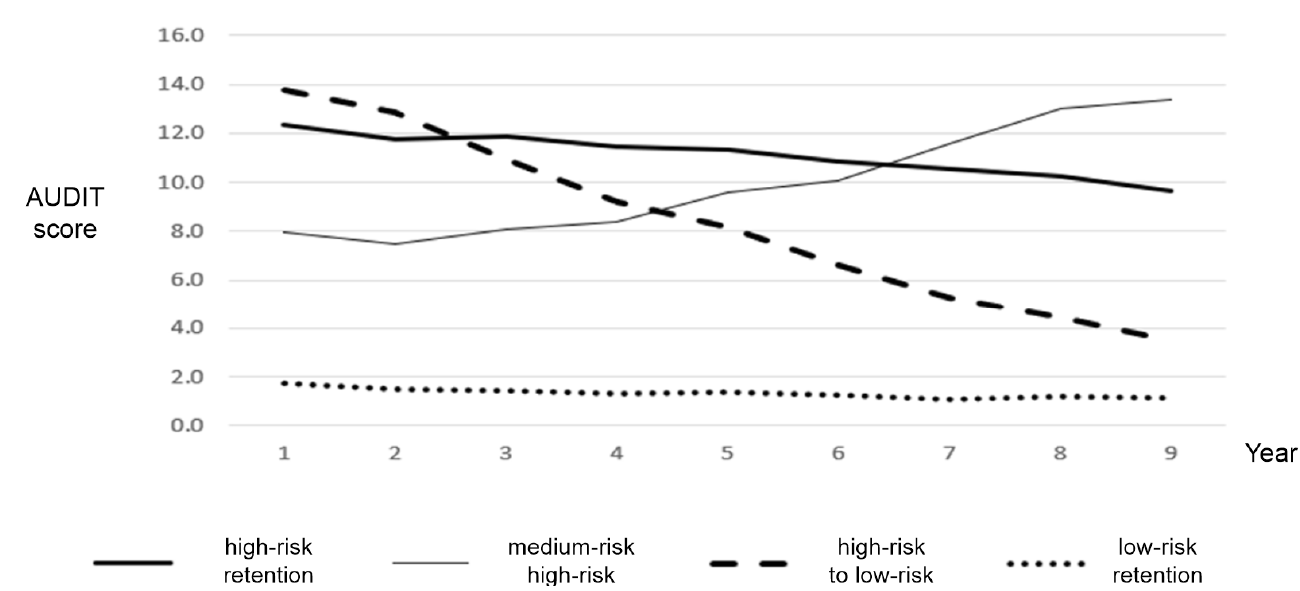
Figure 1. Demographics, socio-economic status, depression and suicidal ideation by types of change in AUDIT score.